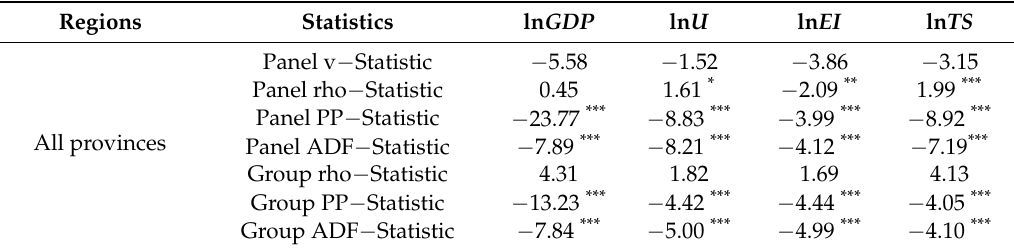
Table A3. Results of the binary cointegration test between lnE and other